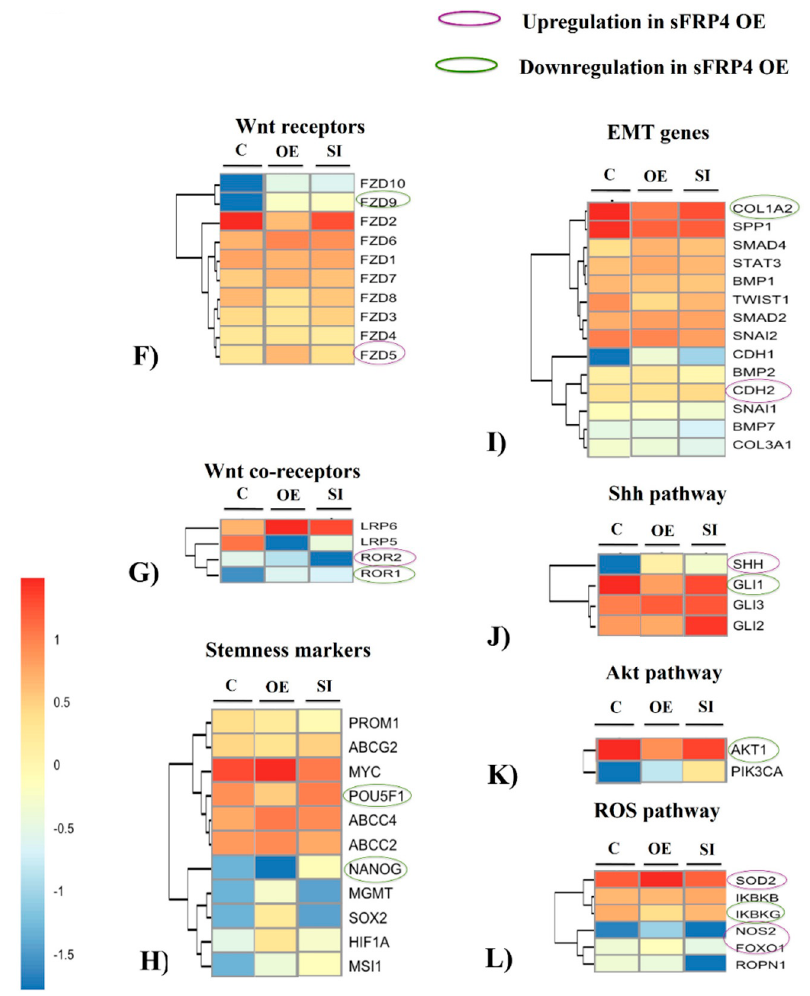
Figure 3. Whole transcriptome analysis of sFRP4 OE, sFRP4 SI, and control indicate variations in expressions between sFRP4 OE and sFRP4 SI. Cell cycle pathway genes ( A ), Wnt canonical pathway ( B ), Wnt Ca 2+ pathway ( C ), Wnt PCP pathway ( D ), Wnt antagonists ( E ), Wnt receptors ( F ), Wnt co-receptors ( G ), Stemness markers ( H ), EMT genes ( I ), Shh pathway ( J ), AKT pathway ( K ) and ROS genes ( L ). Upregulation indicated by violet circle and downregulation by green circle.